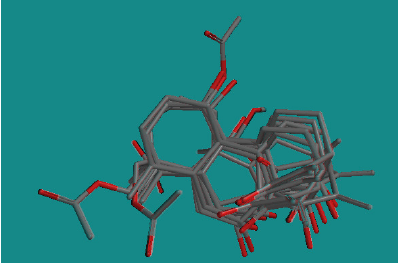
Figure 2. Structural alignment of the 7 compounds with ent -kaurenoic